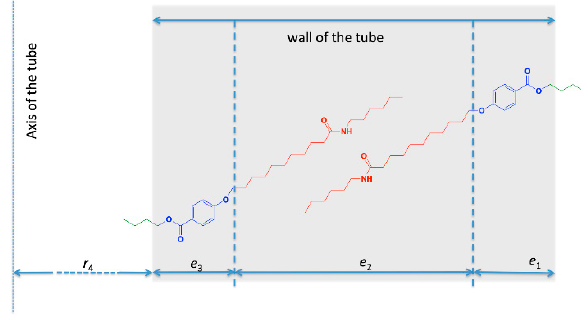
Figure 9. Proposed model for the self-assembly of HUB-4. The tilt angles are arbitrary. The amides are H-bonded with each other.